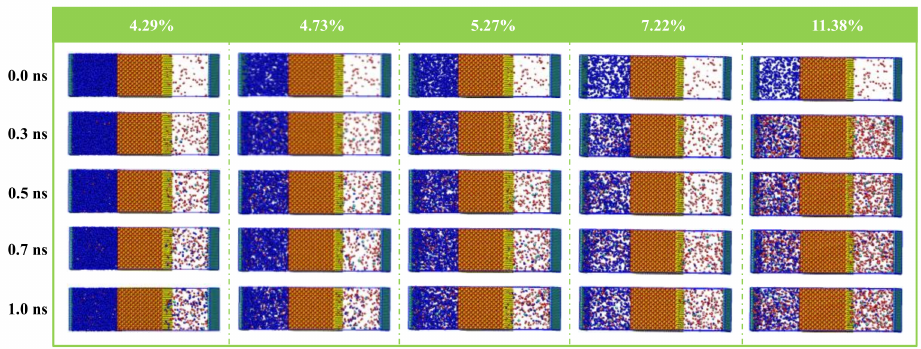
Figure 2. Side views for the evolution of N 2 flooding from 0 to 1